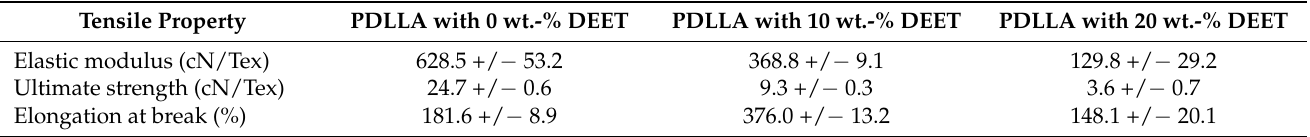
Figure 10. Representative stress − strain curves of PDLLA filaments with varying DEET content. Table 5. Tensile properties PDLLA filaments with varying DEET content.